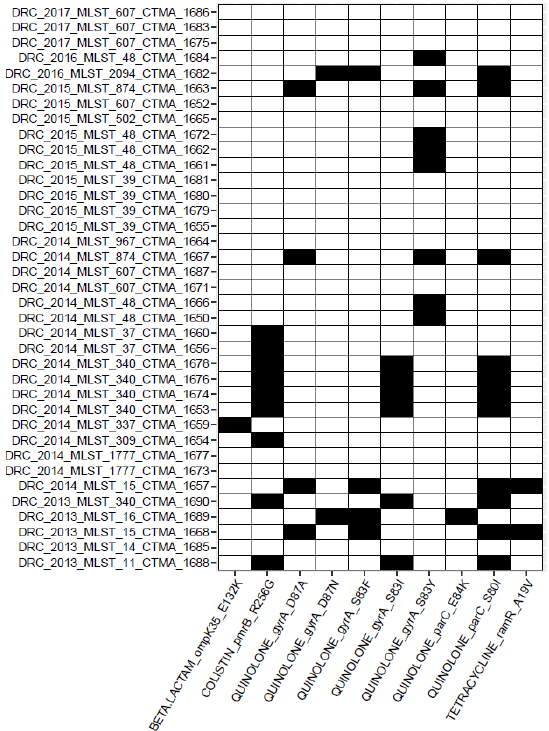
Figure 3. Heatmap of antimicrobial resistance (AMR) point mutations identified with the AMRFinder tool. Black cells indicate the presence of the corresponding SNP